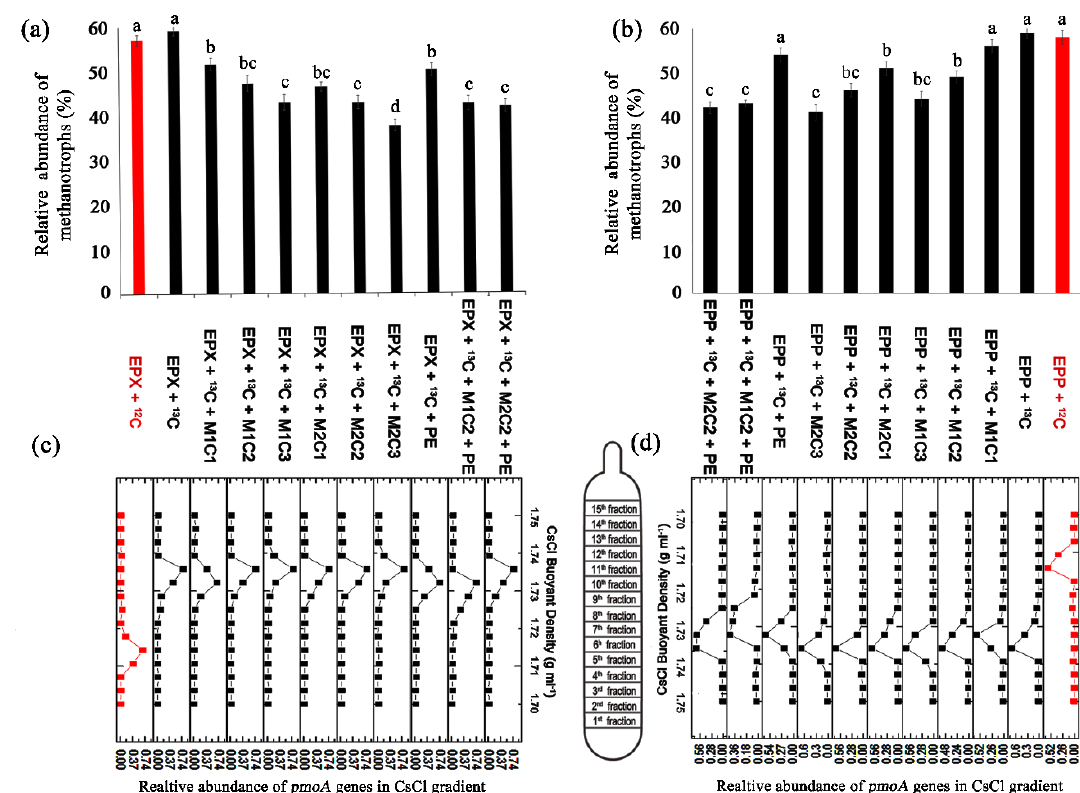
Figure 8. Relative abundances of pmoA genes of the methane-derived heavy fraction, calculated from each fraction to the total abundance throughout the treatment. Red columns represent the light fraction and black columns represent heavy fractions: 13 C-methane-derived pmoA genes abundance from heavy fraction of ( a ) epixylon and ( b ) epiphyton. Gradient distribution of heavy (buoyant density around 1.735) and light (buoyant density around 1.715) fractions in ( c ) epixylon and ( d ) epiphyton. The data